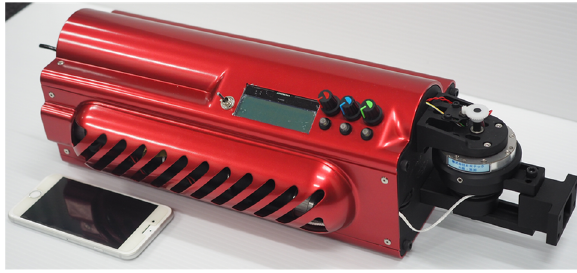
Figure 1. Picture of variable viscoelastic Joint Module.